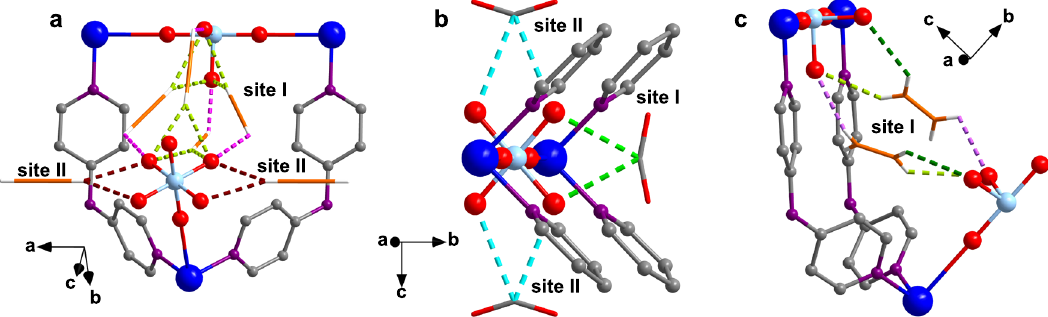
Fig. 4 | Single crystal structure of gas-loaded ZNU-6. a C 2 H 2 @ ZNU-6 [Cu 6 (GeF 6 ) 6 (TPA) 8 (C 2 H 2 ) 25.78 ]; b CO 2 @ ZNU-6 [Cu 6 (GeF 6 ) 6 (TPA) 8 (CO 2 ) 18 ]; c C 2 H 4 @ ZNU-6 [Cu